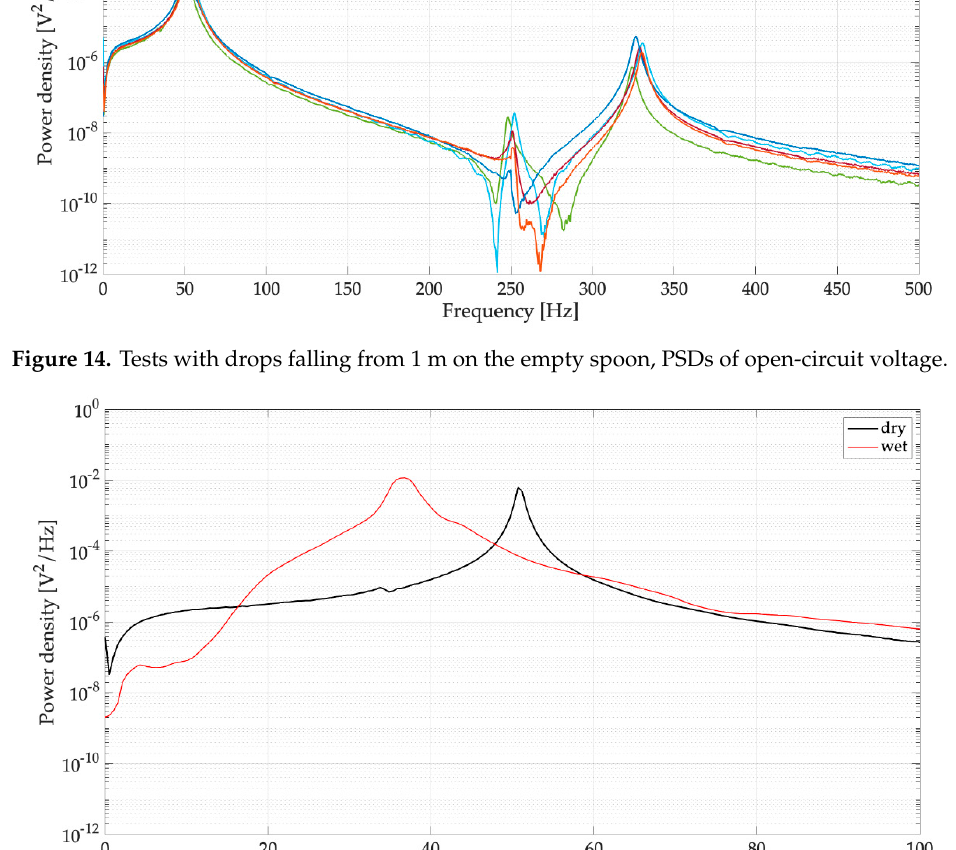
Figure 15. Effect of the filled spoon on the PSDs of open-circuit voltage (dry: harvester with empty spoon, wet: spoon filled with water). To confirm the large beneficial effect of the impact on the liquid surface and the negative effect of water mass, further specific experiments were carried out.